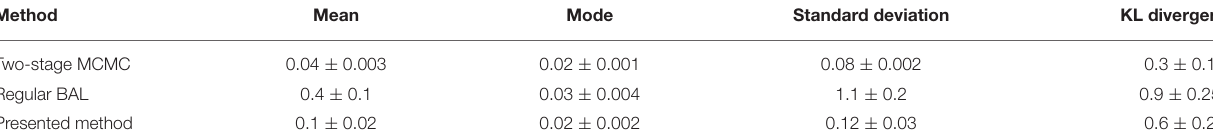
TABLE 1 | Absolute errors in the estimated mean, mode, and standard deviation of the estimated posterior pdf and its KL divergence against directly sampling the exact posterior pdf: the presented method vs. sampling the surrogate from regular Bayesian active learning (regular BAL) vs. two-stage MCMC.